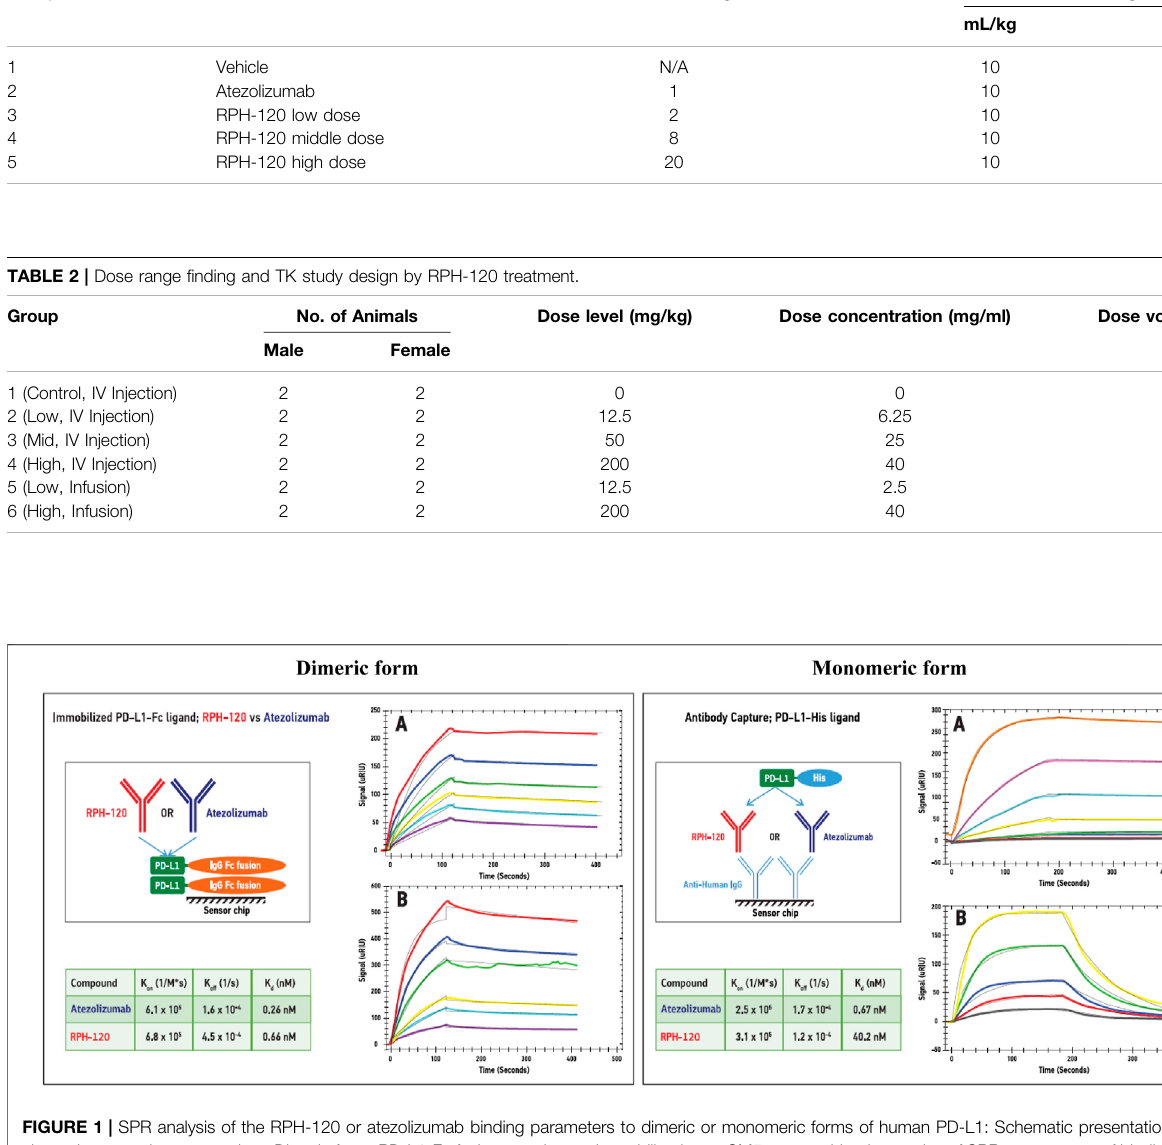
Frontiers in Pharmacology |